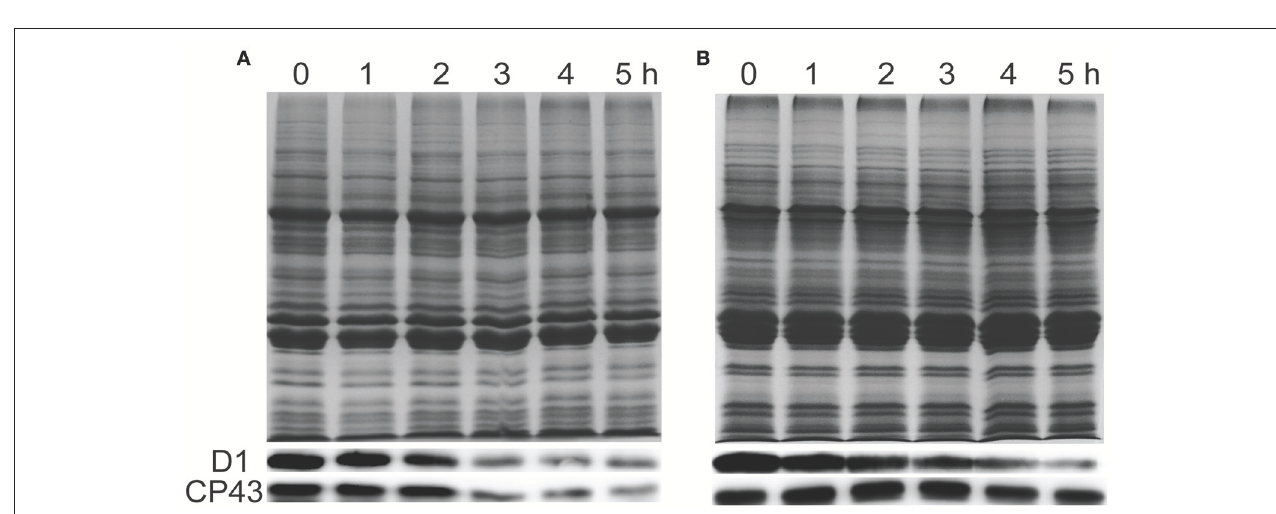
causing alkalization of the medium. In this study, the cells were on the CO 2 assimilation rate. If the dissolution rate of CO 2 is greater than that of assimilation, the continuous CO 2 dissolution results in the accumulation of HCO − and H + , so excessive CO 2 and NaNO 3 were the main carbon and nitrogen source. The 3